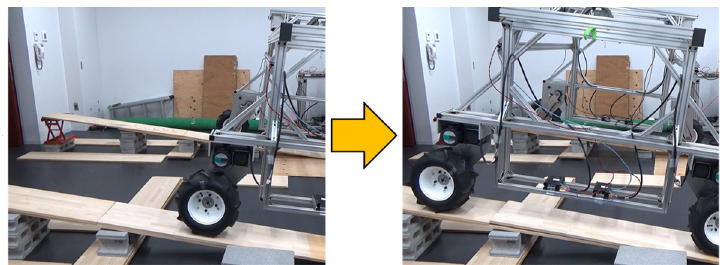
Figure 15. 7.5° slope climbing test. Figure 15. 7.5 ◦ slope climbing test.